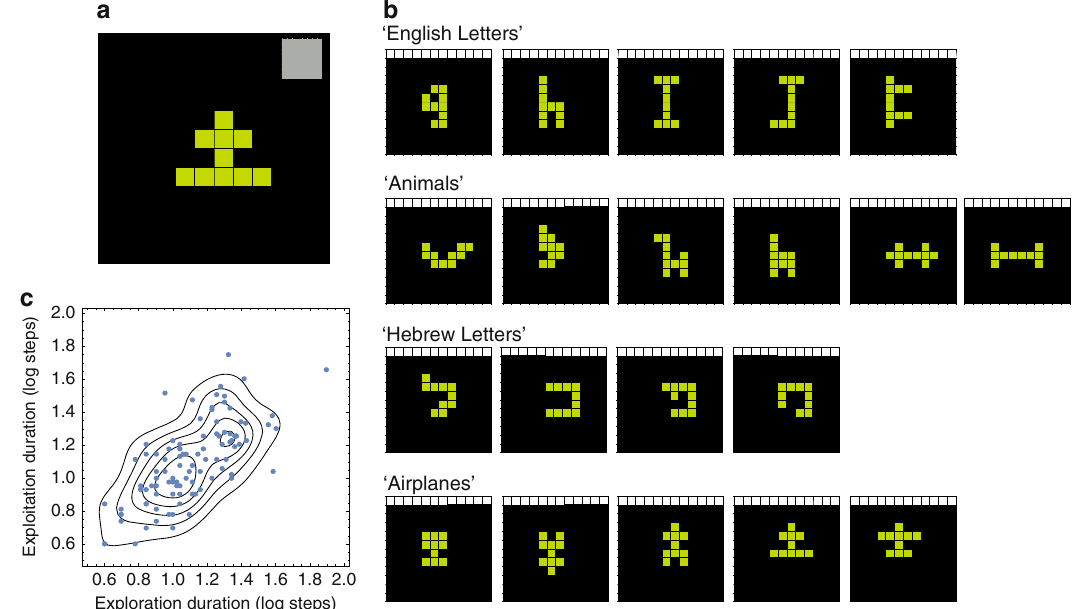
Fig. 1 The creative foraging game as a paradigm to study creative search. a A schematic of the creative foraging game screen that players use to search for shapes. Each step is a move of one square, keeping the ten squares connected. Players can choose shapes to a gallery (previously chosen gallery shape is presented in the gray square area at the top right). b In exploitation phases, players typically collect shapes from distinct visual categories (e.g., ‘ English Letters ’ , ‘ Animals ’ , ‘ Hebrew Letters ’ , ‘ Airplanes ’ , etc … ). Each row of shapes is one exploitation phase of a player in the game. c Variation between players shows a high correlarion between each player's median durations of exploration and exploitation phases. Blue points indicate players ’ median search durations in the exploration-exploitation duration plane (in log steps). Topographic map indicates lines of equal density of exploration-exploitation